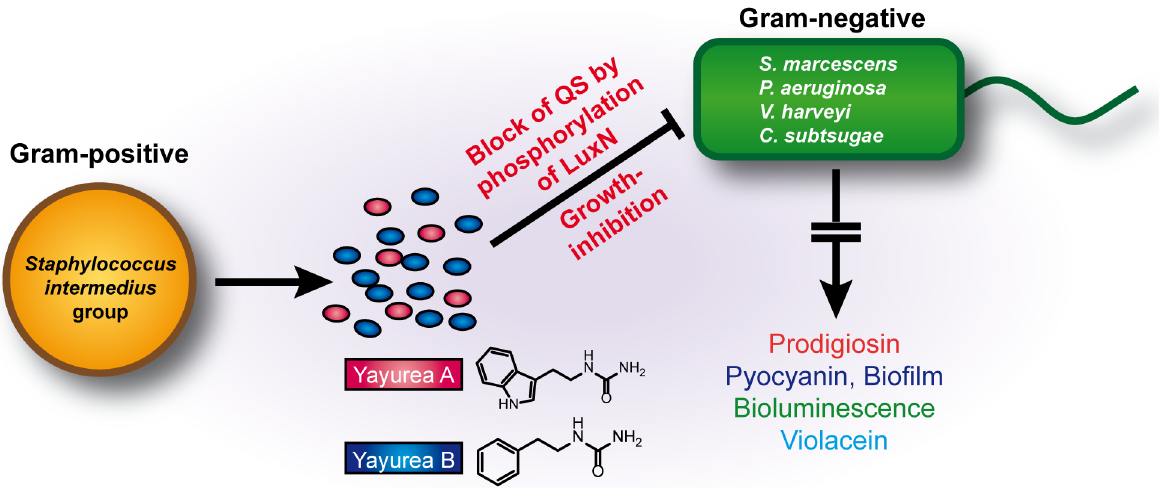
Figure 8. Schematic presentation of the interference between zoonotic staphylococcal species and Gram-negative bacteria. Animal associated (zoonotic) Staphylococcus species excrete novel quorum-quenching compounds, yayurea A and B, which block quorum sensing system in various Gram-negative bacteria by activating LuxN phosphorylation and have also growth inhibiting activity. The benefit for the staphylococcal species is better survival and increased competitiveness in a joint ecosystem.